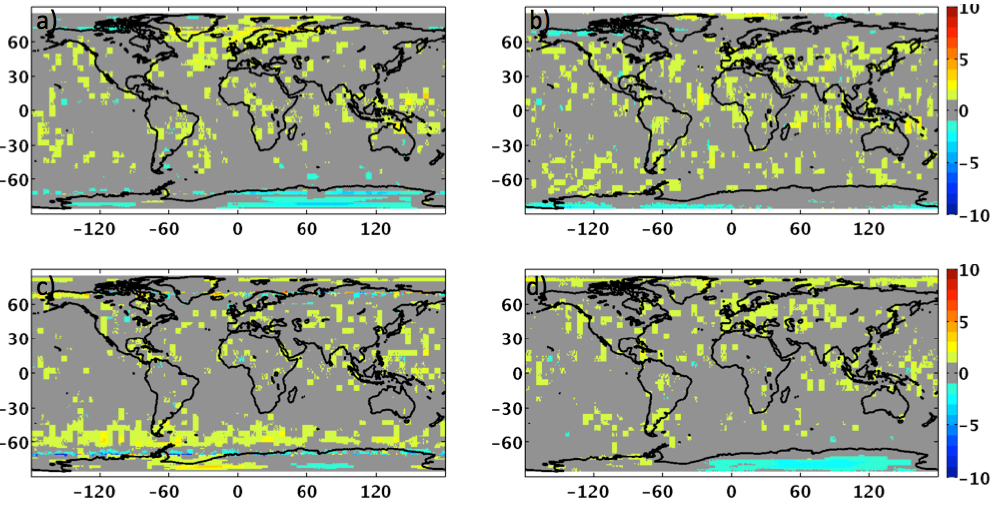
Figure 2. Monthly regional mean longwave flux error from ADM uncertainties for (a) January, (b) April, (c) July, and (d) October 2002 using Terra